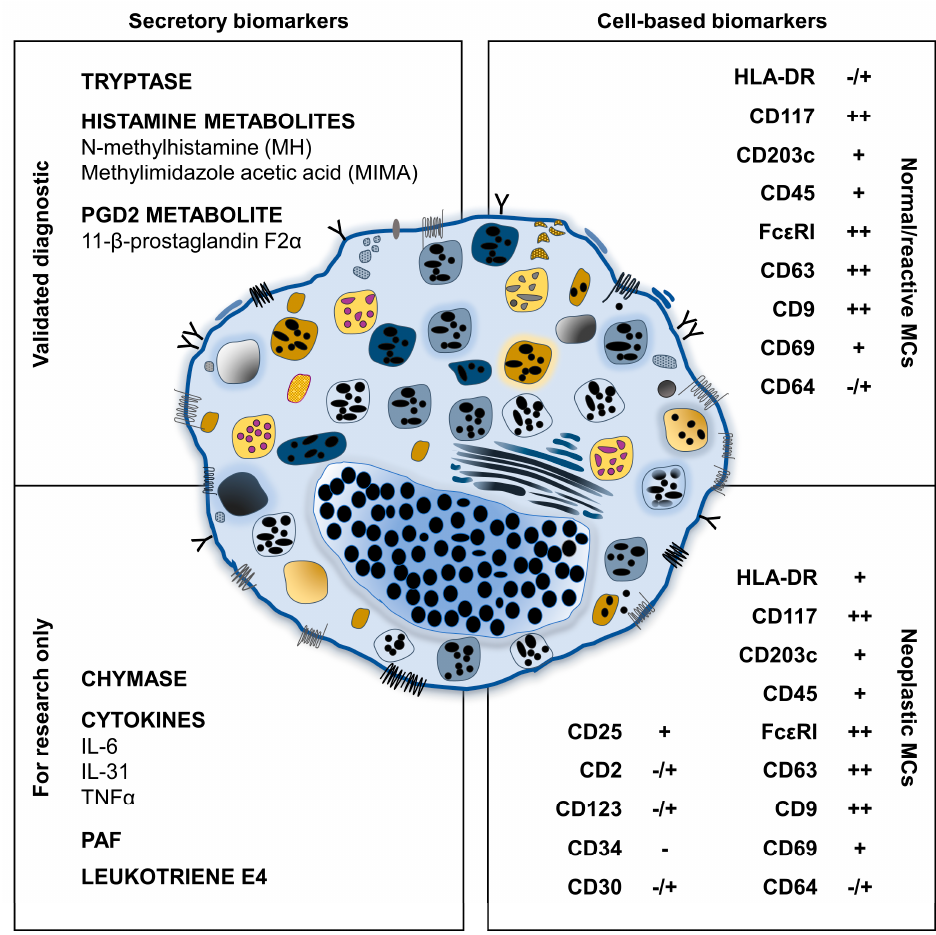
Figure 1. Secretory and membrane-associated MC biomarkers. Circulating biomarkers of MC activation are reported for molecules validated in clinical practice (upper left) or for research use only (bottom left). Cellular biomarkers of normal/reactive (upper right) and neoplastic (bottom right) MC are displayed. Abbreviations. PGD2, prostaglandin D2; IL, interleukin; TNF α , tumor necrosis factor alpha; PAF, platelet activating factor. ++, bright expression; +, expressed; -/+, dim expression; -, not expressed.